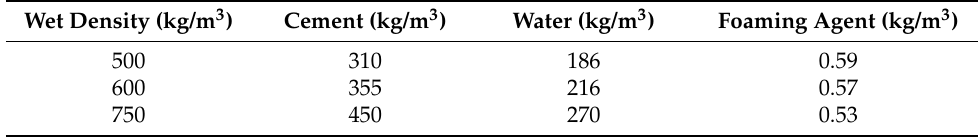
Table 1. Mixtures of foamed concrete.